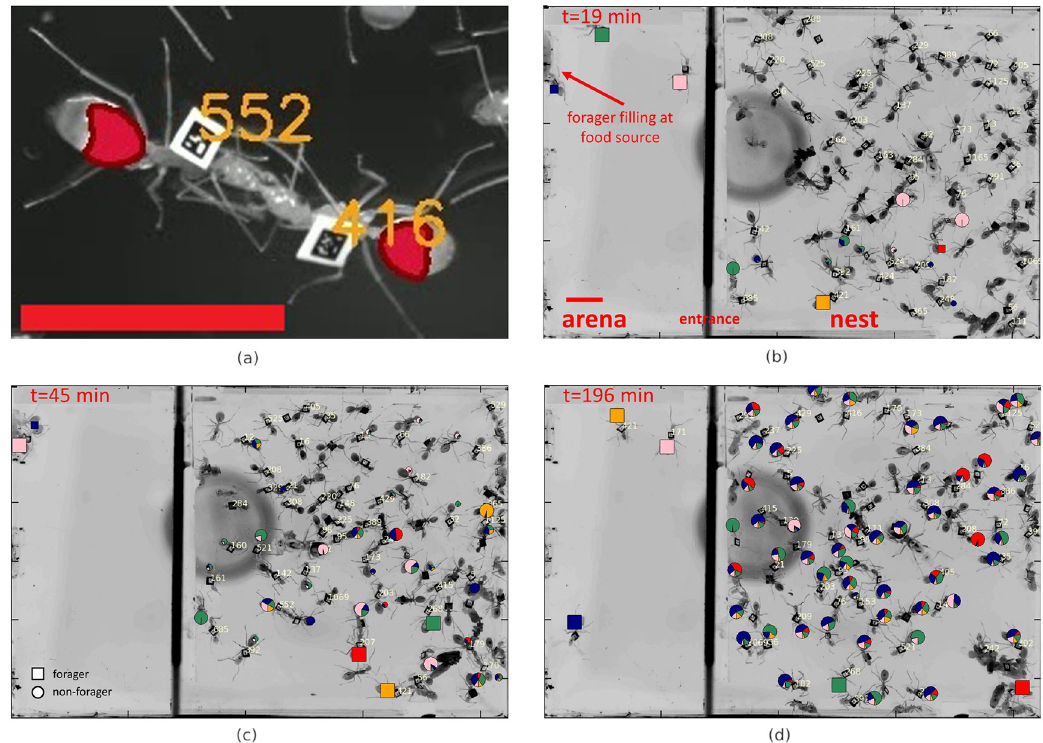
Fig 1. Quantifying food distribution within an ant colony by combining single ant tracking with fluorescent imaging. a) Two tagged workers engaged in trophallaxis. The identity of ants (orange numbers) was determined using Bugtag barcodes. The volume of food in the ants’ crop is measured using fluorescence imaging and overlaid in red. b-d) Food distribution across the colony and at different stages of the experiment. Markers (round: non-forager, square: forager) overlaid on ants depict their crop contents. Marker size is proportional to the food load held by each ant: P a (small markers were set to a minimal size for clarity). Color division in markers of all ants depicts the computationally derived proportions of food in their crops according to the forager that first collected it (‘food-types’): ( P ( f | A = a )). Scale bars are 1cm. See also supplemental movie “Food dissemination in ant